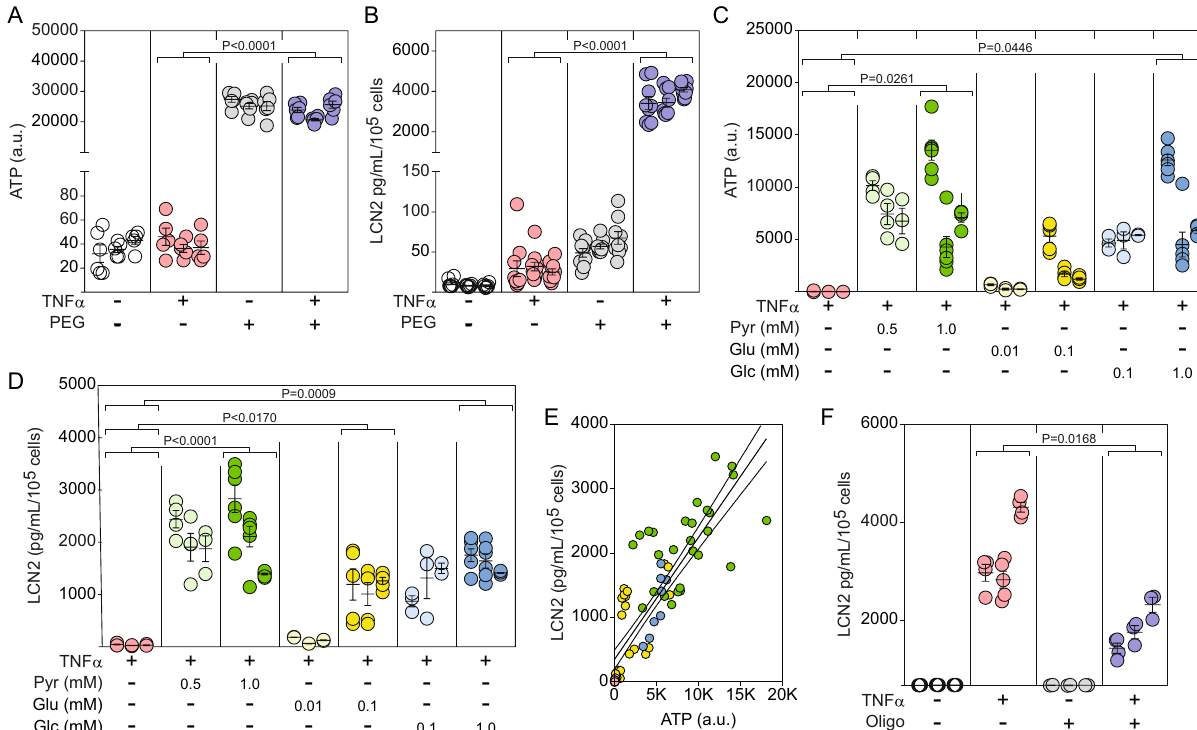
Figure 3. TNFα-induced Lcn2 secretion requires ATP primarily produced by oxidative phosphorylation. ( A ) Intracellular ATP levels were measured in astrocytes stimulated with TNFα (10 ng/mL for 24 h) in serum- free, phenol red-free media deprived of glucose (Glc), pyruvate (Pyr), and glutamate (Glu) or reconstituted with 1 mM pyruvate, 5 μM glutamate, and 1 mM glucose (PEG). Each symbol represents one well from 3 separate experiments, shown in nested layout. Mean ± SEM is shown for each biological replicate. P-values were calculated using mixed model nested t-tests. ( B ) Supernatants from the same cells in ( A ) were assessed for Lcn2 production by ELISA. Each symbol represents one well from 3 separate experiments, shown in nested layout. Mean ± SEM is shown for each biological replicate. P-values were calculated using mixed model nested t-tests. ( C ) Intracellular ATP levels were measured in astrocytes stimulated with TNFα (10 ng/mL for 24 h) in serum-free, phenol red-free media deprived of pyruvate (Pyr), glutamate (Glu), and glucose (Glc) individually reconstituted with each factor at different concentrations. Each symbol represents one well from 3 separate experiments, shown in nested layout. Mean ± SEM is shown for each biological replicate. P-values were calculated using mixed model nested ANOVA between treatment conditions. ( D ) Cell supernatants from the same cells in ( C ) were assessed for Lcn2 production by ELISA. Each symbol represents one well from 3 separate experiments, shown in nested layout. Mean ± SEM is shown for each biological replicate. P-values were calculated using mixed model nested ANOVA between treatment conditions. ( E ) Linear regression indicates that Lcn2 concentration is correlated with intracellular ATP concentration (R 2 = 0.761) Solid line shows regression fit, with 95% CI shown as dotted lines. ( F ) Astrocytes were treated with the mitochondrial complex III inhibitor oligomycin (Oligo) (1 μM) for 30 min prior to stimulation with TNFα (10 ng/mL) for 24 h. Secreted Lcn2 was measured in supernatants by ELISA. Each symbol represents one well from 3 separate experiments, shown in nested layout. Mean ± SEM is shown for each biological replicate. P-values were calculated using mixed model nested ANOVA between treatment